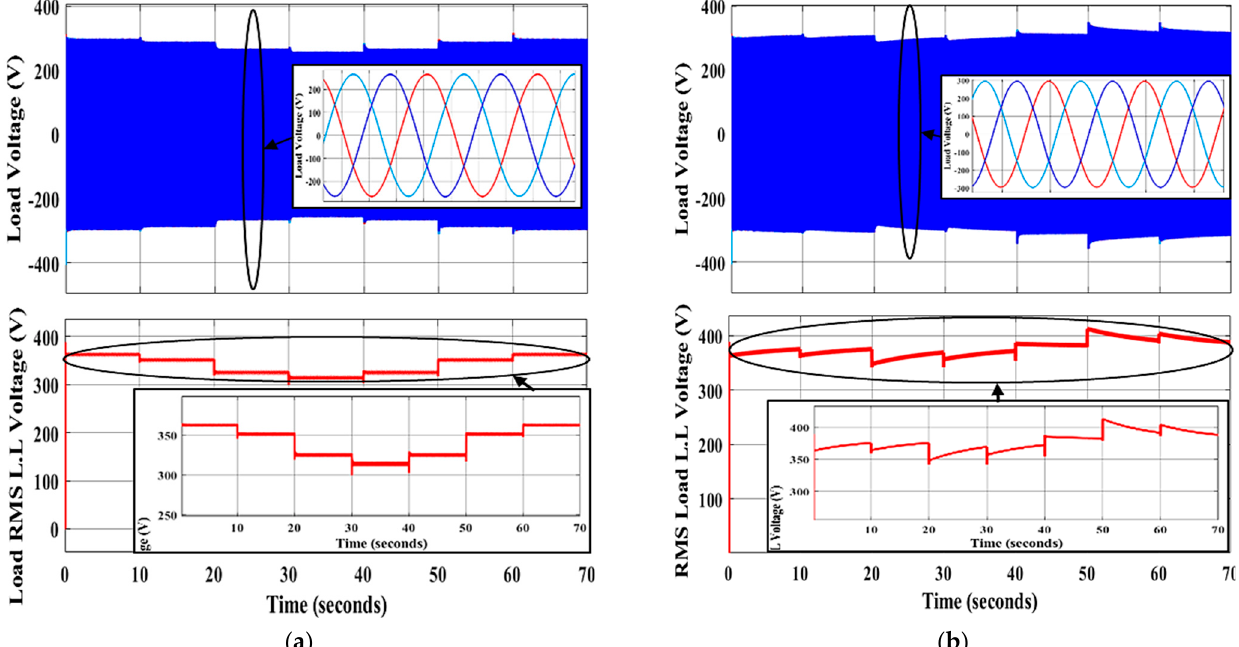
Figure 9. The system voltage using primary control in ( a ) and with applying GA-based SCUs in ( b ).